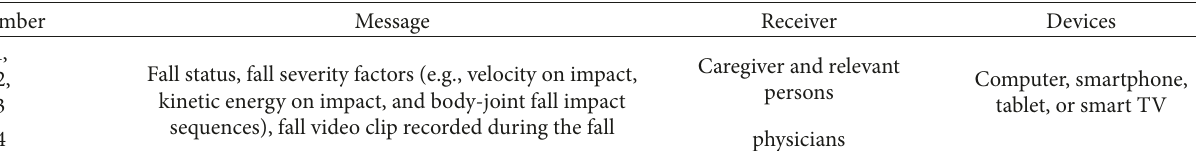
Table 2: Types of message